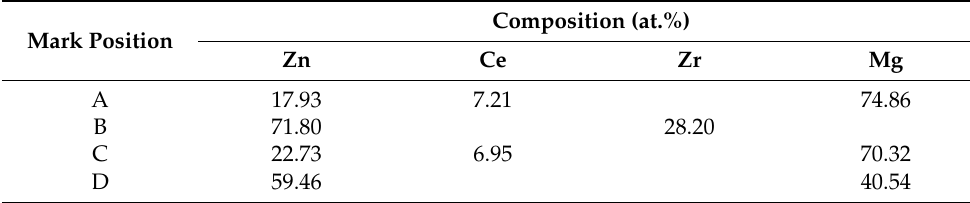
Table 2. EDS Analysis Results of Typical Alloy Solid Phase Separation.